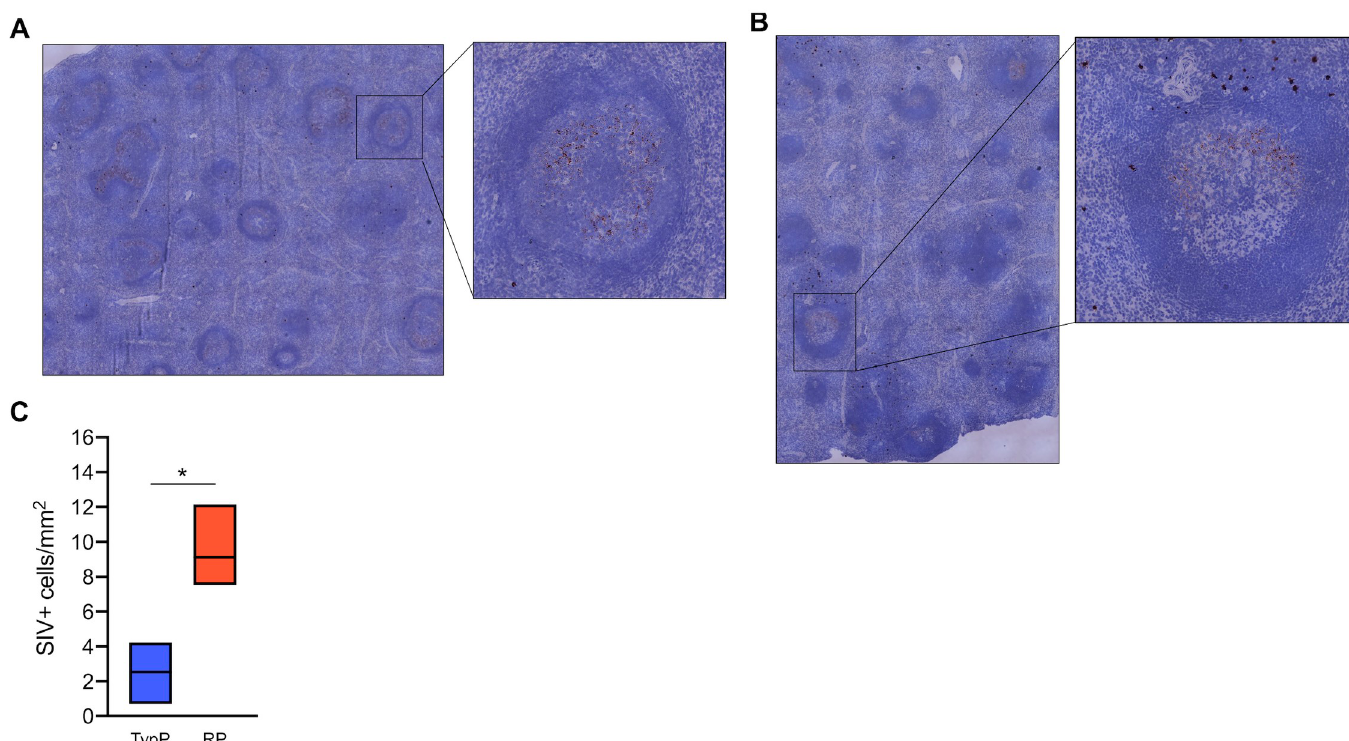
Fig 9. Rapidly progressing infants have more SIV infected cells localized outside of splenic germinal centers. RNAscope in situ hybridization using SIV-specific RNA probes was used to detect SIV-infected cells and cell-free virus in the spleens of TypP ( A ) and RP ( B ) infants. SIV+ cells were quantified across stitched images and normalized for area of splenic tissue ( C ). Statistical tests used to compare infant groups were carried out as described in the methods � = p < 0.05. Error bars are shown as floating bars (min to max) with line indicating the mean. n = 3 per group.